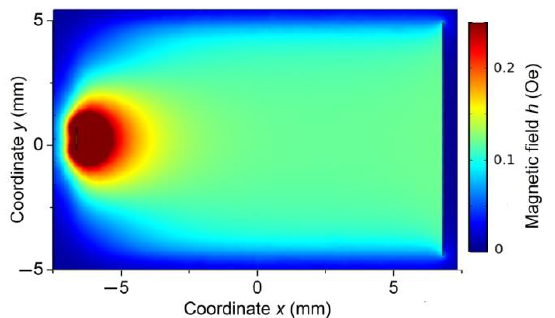
Figure 3. Spatial distribution of the magnetic field h y inside the "magnetic capacitor" for I = 100 mA and z = 0.